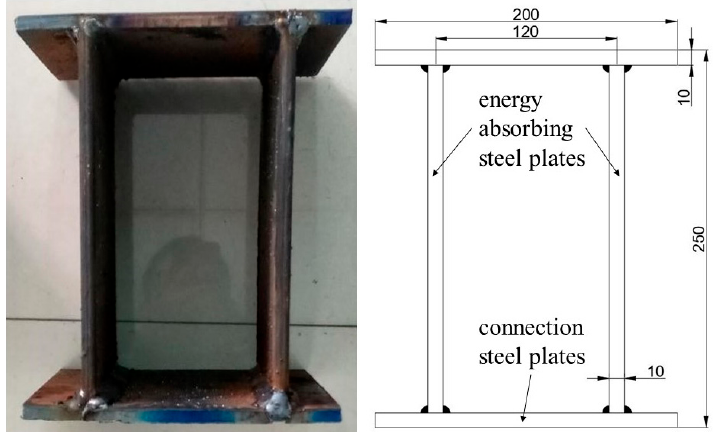
Figure 3. Linear energy-absorbing damper (LED).